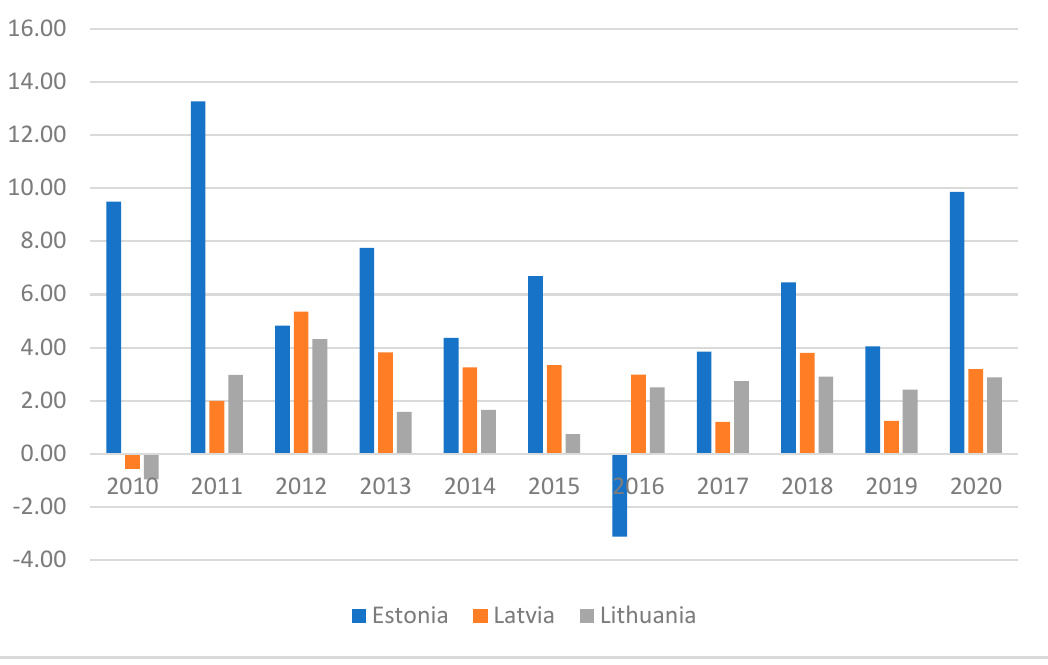
Figure 3. Foreign direct investment dynamics in the Baltic states over the period of 2010–2020.